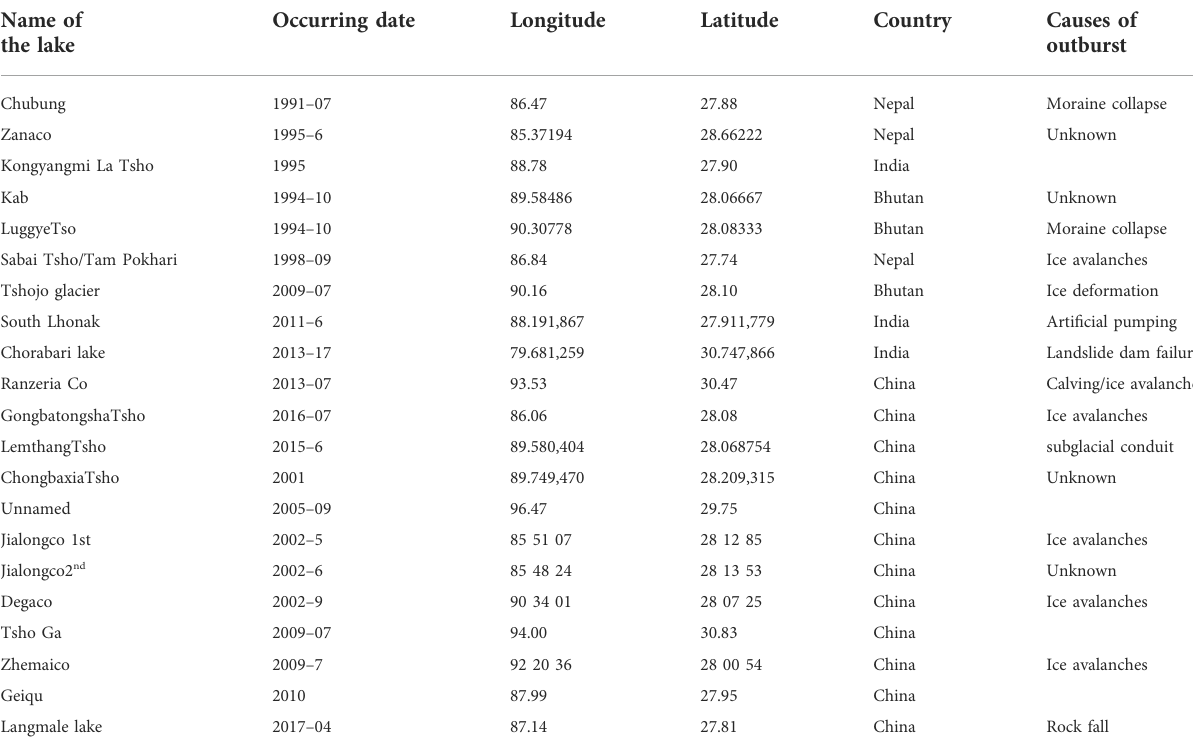
TABLE 3 Number, causes and locations of GLOF events reported in the Himalaya since 1990.